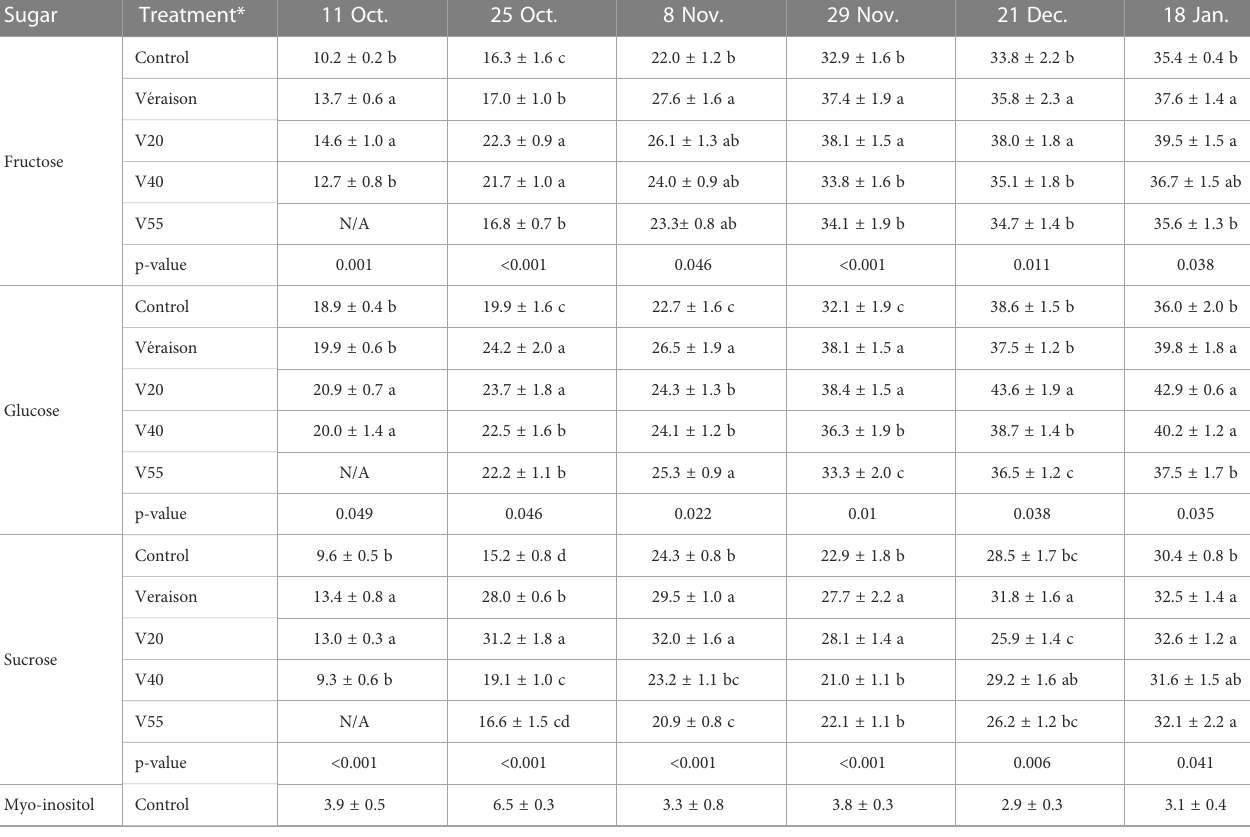
TABLE 2 Effect of ABA on the seasonal changes of the sugar concentrations (mg/g dry wt) in ‘ Cabernet franc ’ .